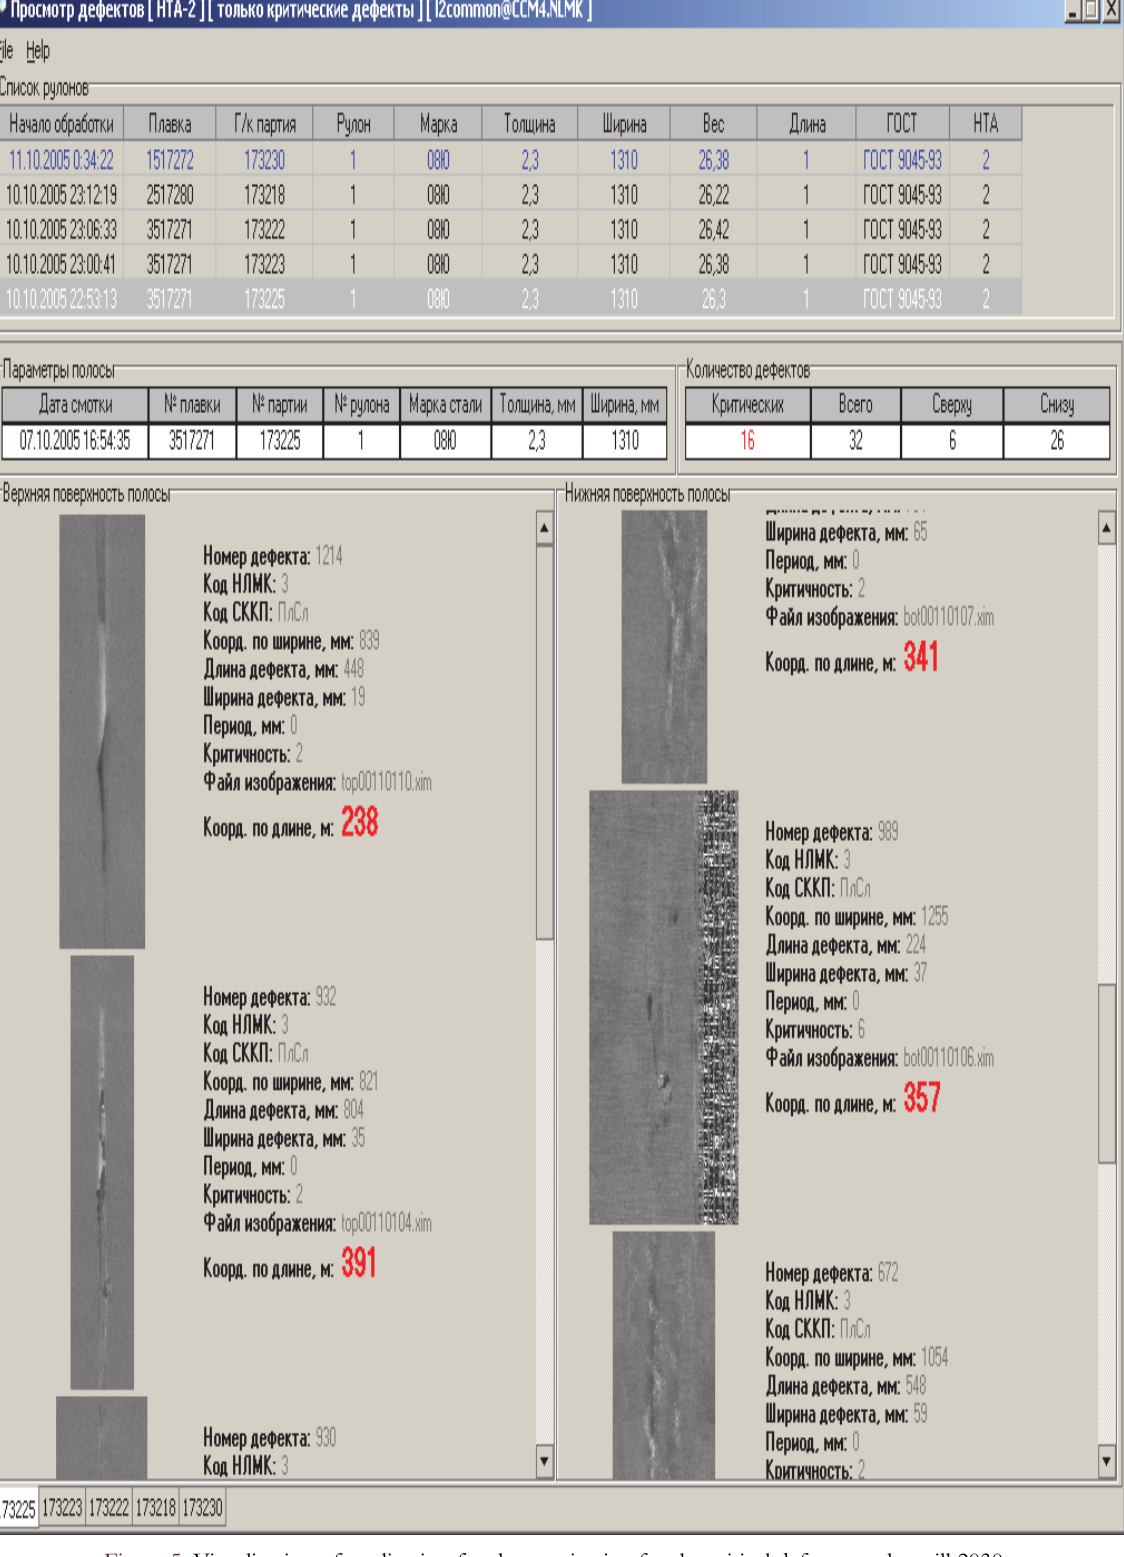
Figure 5: Visualization of application for the monitoring for the critical defects on the mill